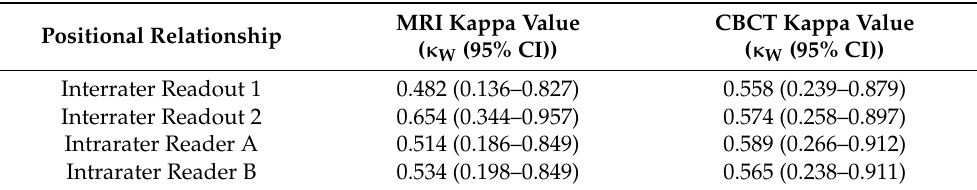
Table 1. The inter- and intra-rater agreement regarding the classification of the positional relationship between the IAN/MC and the